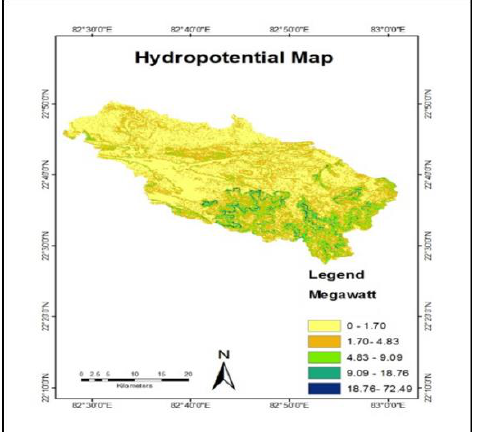
Figure 9. Hydro potential map of the desired watershed. The power potential (P) was calculated using the formula; P = q * m * g * h. Calculated results shows that hilly area is having maximum power potential up to 72Mw as height (head drop) is one of the main factor included in it and site which are suitable for hydropower development are having power potential up to 18 Mw (Fig.9).